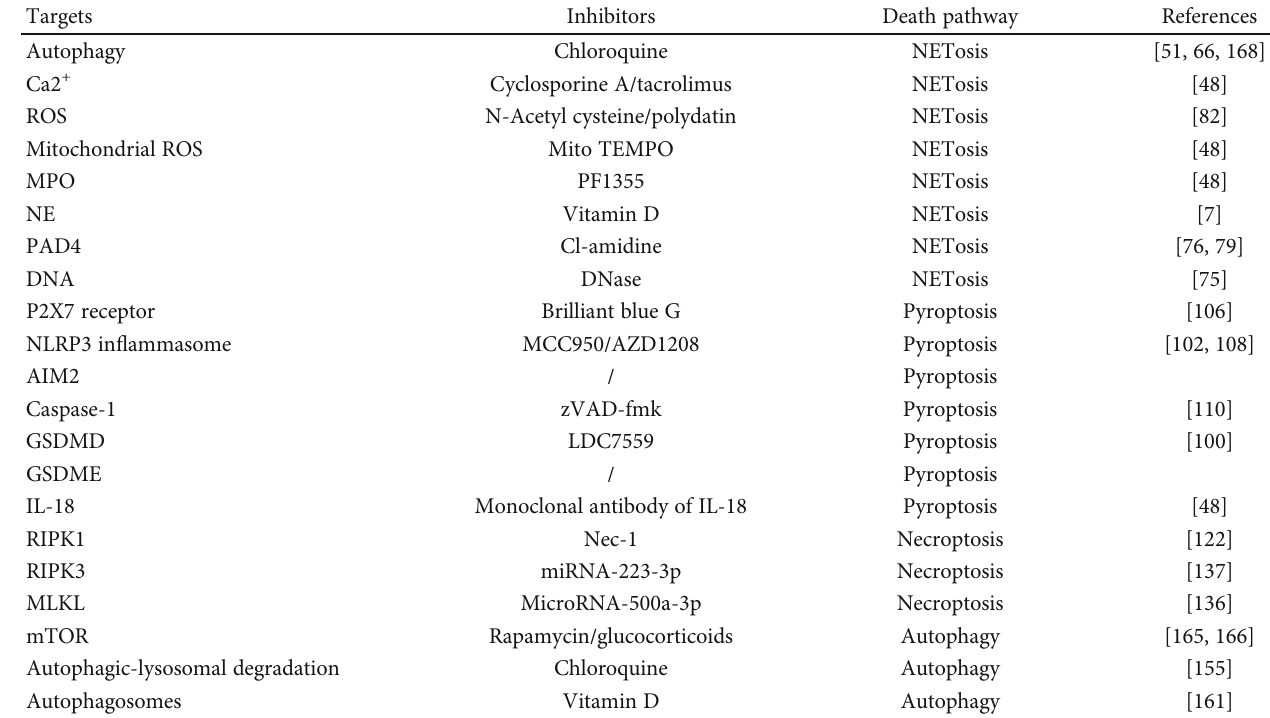
Table 1: Possible therapeutic targets for